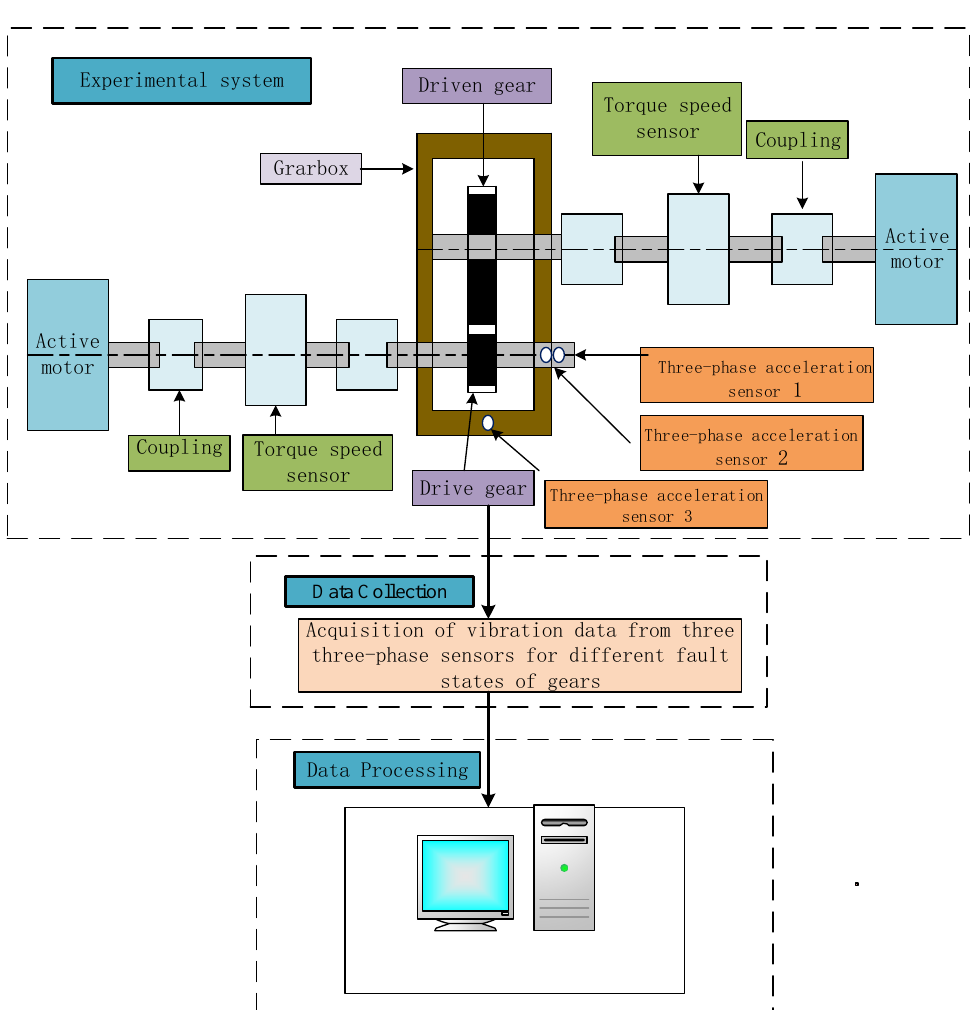
Figure 9. Structural design of the experimental gear.